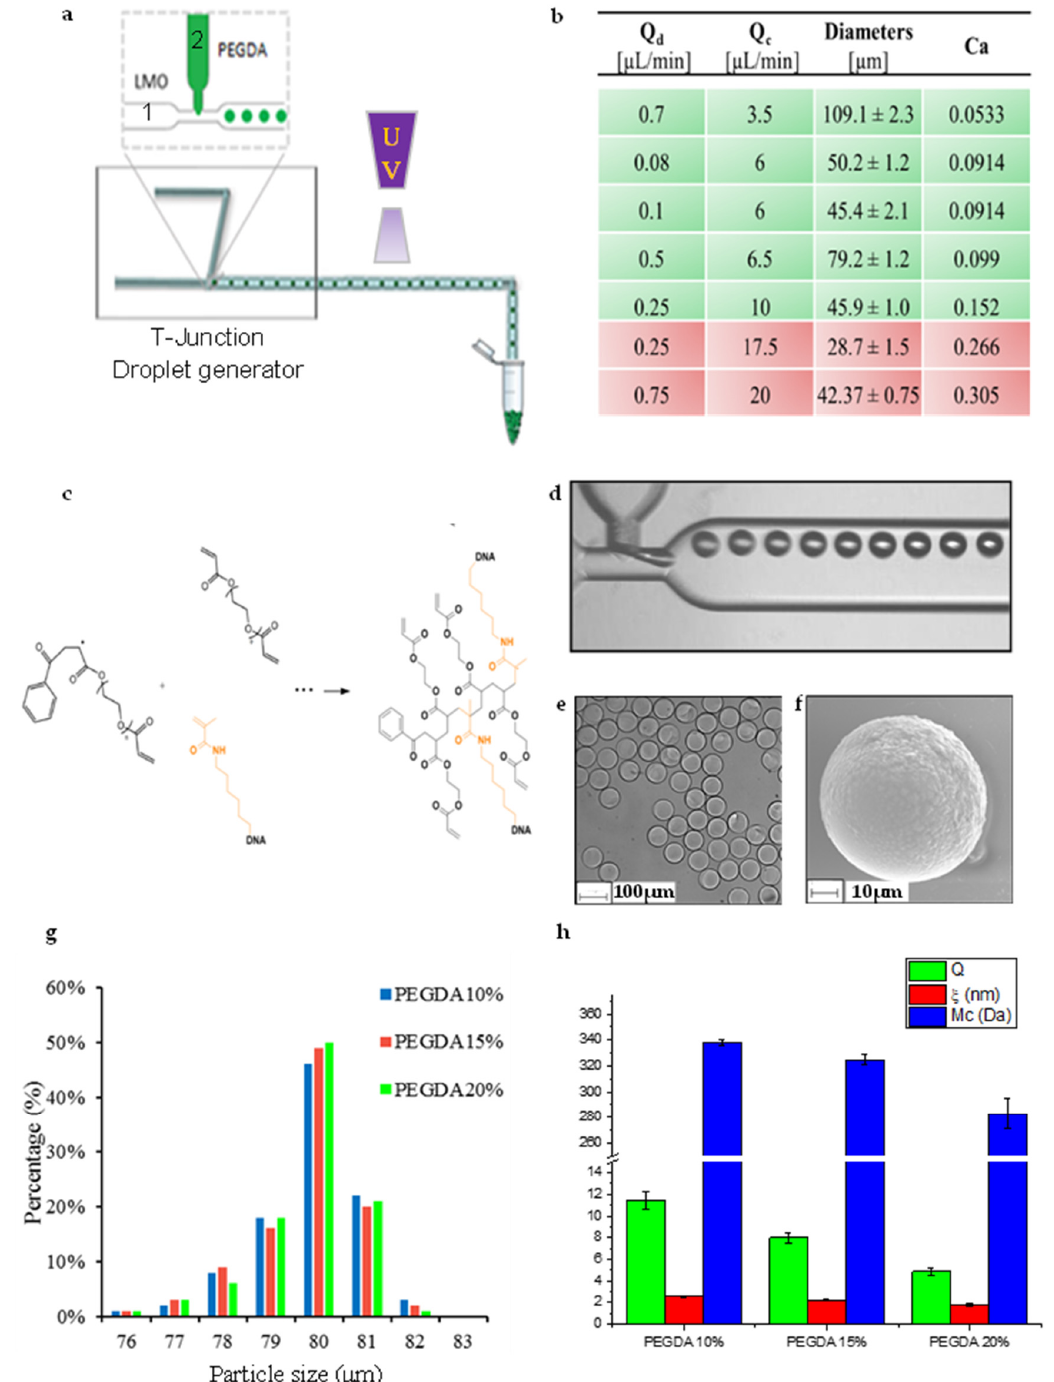
Figure 1. ( a ) Schematic representation of microfluidic synthesis set-up for microparticles production; ( b ) Table of PEGDA pre-polymer flow rate ( Qd ), LMO flow rate ( Qc ), diameters of water in oil emulsion and capillary number ( Ca ); ( c ) UV free radical photopolymerization between PEGDA and methacrylate oligonucleotide; ( d ) Droplet generation by microfluidic T-junction device; ( e ) Optical image of monodisperse microparticle; ( f ) SEM image of microparticle; ( g ) Size distribution of functionalized microparticles (PEGDA 10–15–20% w / v ); ( h ) Swelling parameters (Q, ξ , Mc) for different polymer concentrations.